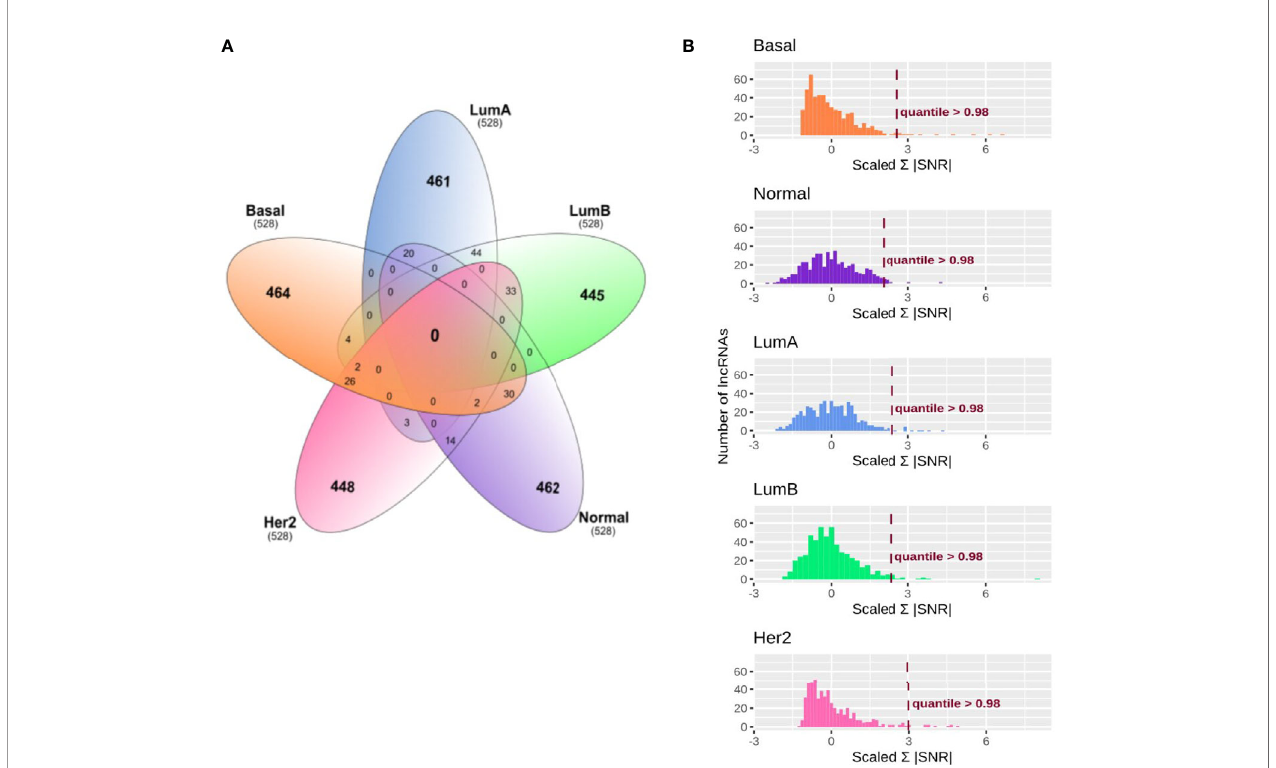
FIGURE 2 | Immune related lncRNAs fi lter and selection in breast cancer (BRCA) molecular subtypes. (A) Venn diagram representing speci fi c and shared immune related lncRNAs in breast cancer molecular subtypes. After fi ltering for 0.95 quantile in signal to noise ratio (SNR) for the BRCA molecular subtypes, 528 lncRNAs were selected for the next analysis. (B) Absolute SNR sum fi lter selection. SNR was calculated within each BRCA molecular subtype for the immune subtypes. Only groups with more than fi ve patients were used. The histograms represent the amount of lncRNAs in each range of absolute SNR sum for the BRCA molecular subtypes. X-axis was scaled for z-score to allow comparison. The lncRNAs were fi ltered according to the 0.98 quantile as represented as the dashed line on the